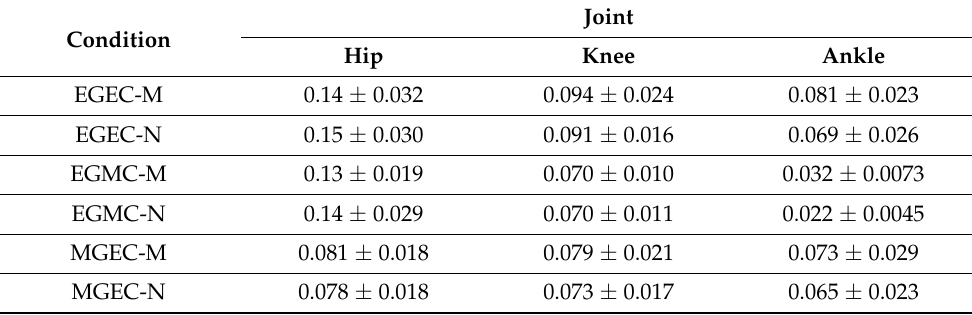
Table 5. RMSE of joint torques averaged across all the trials and subjects for all the conditions: (i) estimated GRF and COP with musculoskeletal model (EGEC-M), (ii) estimated GRF and COP with neuromusculoskeletal model (EGEC-N), (iii) estimated GRF and measured COP with musculoskeletal model (EGMC-M), (iv) estimated GRF and measured COP with neuromusculoskeletal model (EGMC- N), (v) measured GRF and estimated COP with musculoskeletal model (MGEC-M), (vi) measured GRF and estimated COP with neuromusculoskeletal model (MGEC-N). The unit for RMSE is Nm/kg. Joint Condition Hip Knee Ankle EGEC-M 0.14 ± 0.032 0.094 ± 0.024 0.081 ± 0.023 EGEC-N 0.15 ± 0.030 0.091 ± 0.016 0.069 ± 0.026 EGMC-M 0.13 ± 0.019 0.070 ±